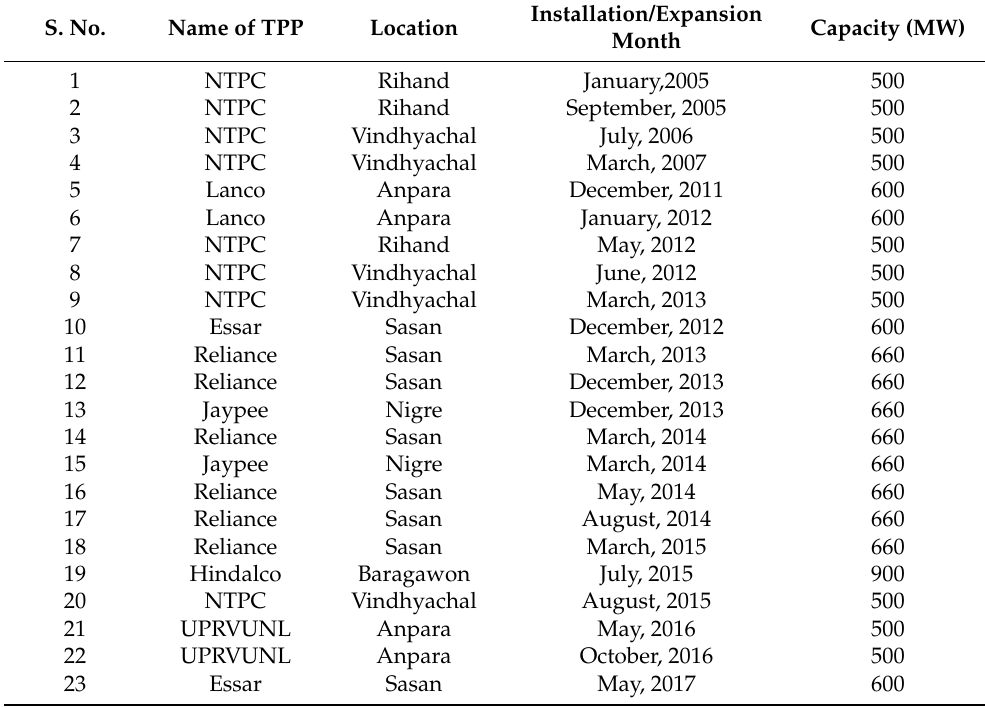
Table 1. Location of various TPPs in the study area showing installation date and further expansion months. These details are extracted from the individual website of the corporations that have installed coal-based TPPs in the study